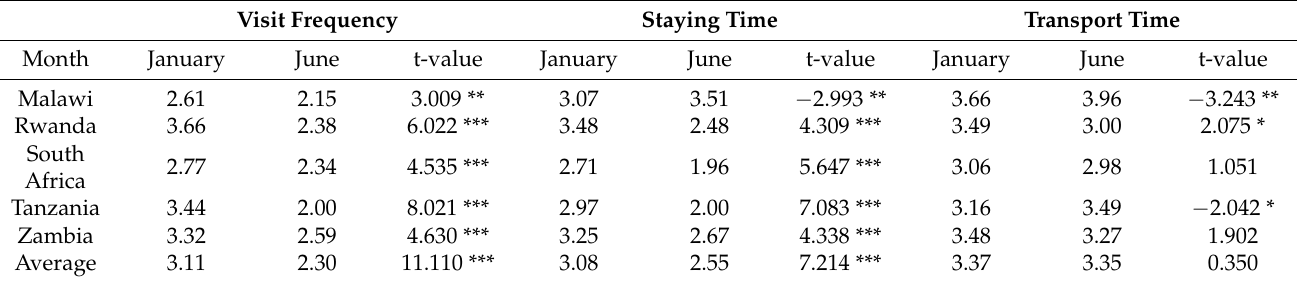
Table 4. Changed outdoor recreation behavior during COVID-19 pandemic. Staying Time Transport